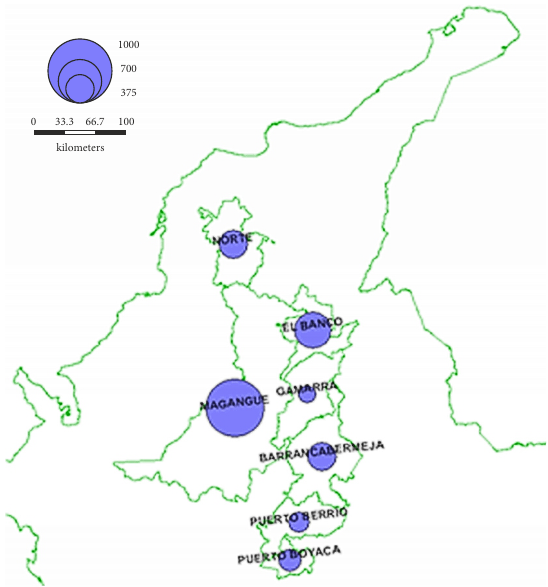
Figure 5. Attracted trips by